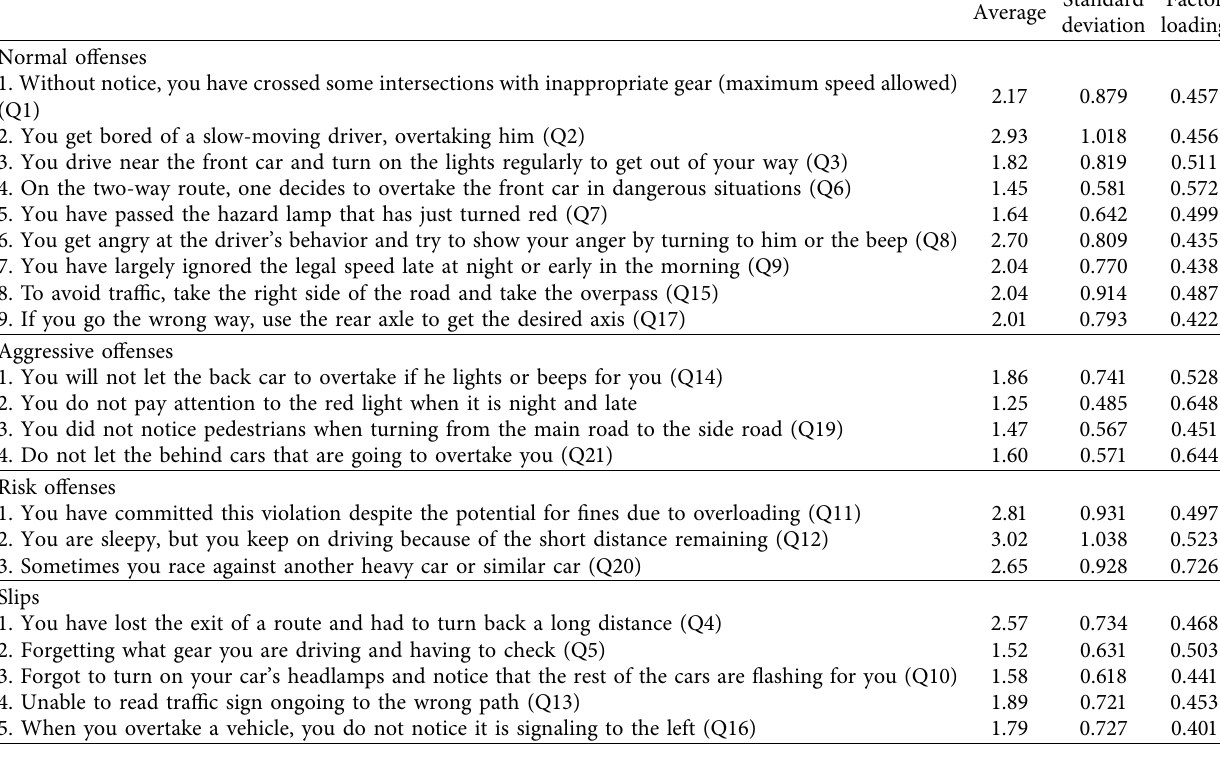
Table 3: Statistic summary of DBQ information.